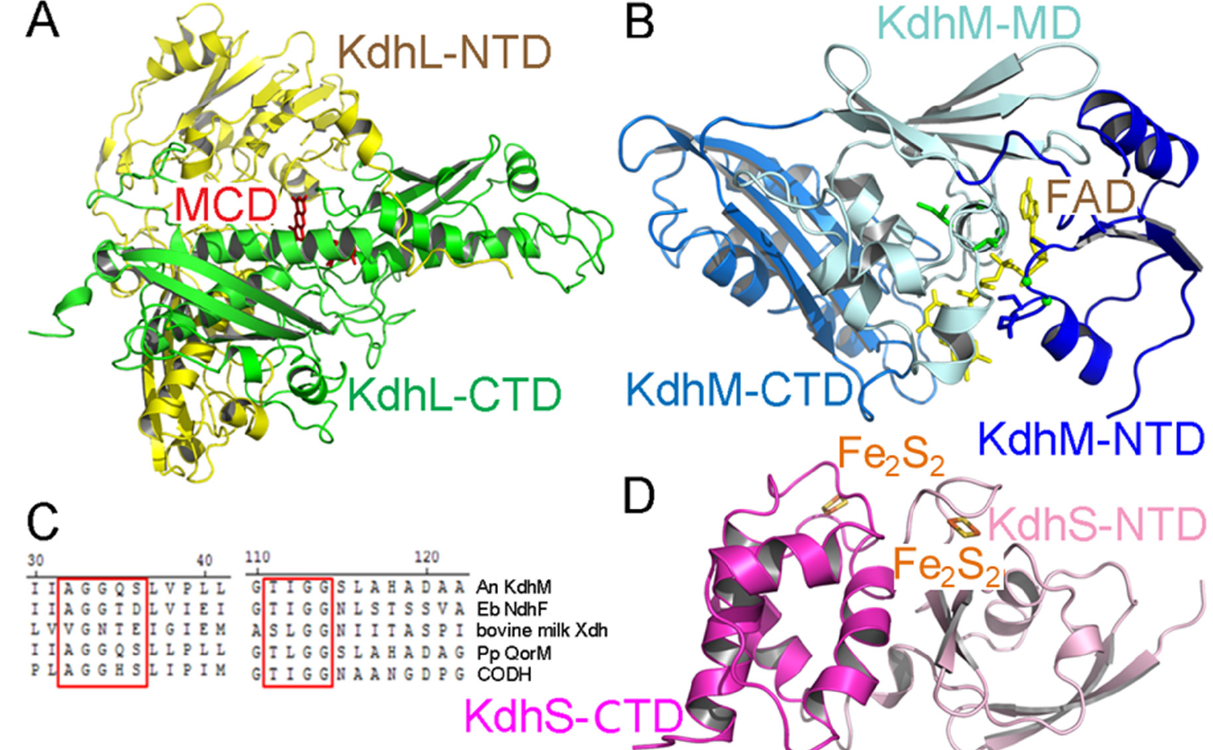
Figure 2. Structure of each subunit of Kdh. ( A ) Structure of KdhL. The N-terminal domain (NTD) and the C-terminal domain (CTD) of KdhL are colored in yellow and green, respectively. The MCD cofactor is colored in red. ( B ) Structure of KdhM. The NTD, middle domain (MD), and CTD of KdhM are colored in blue, pale cyan, and marine, respectively. The FAD cofactor is colored in yellow. Amino acid residues from the 2 FAD-binding motifs of KdhM are displayed in stick representation and colored in green. ( C ) Sequence alignment of the two conserved FAD-binding motifs from various molybdenum hydroxylases. Abbreviations: An KdhM: Arthrobacter nicotinovorans KdhM; Pp QorM: Pseudomonas putida 86 quinoline 2-oxidoreductase M subunit; Eb NdhF: Eubacterium barkeri NdhF; CODH: Oligotropha carboxidovorans carbon monoxide dehydrogenase. ( D ) Structure of KdhS. The NTD and CTD domains of KdhS are colored in pale pink and magenta, respectively. The two Fe 2 S 2 are shown in stick representation.